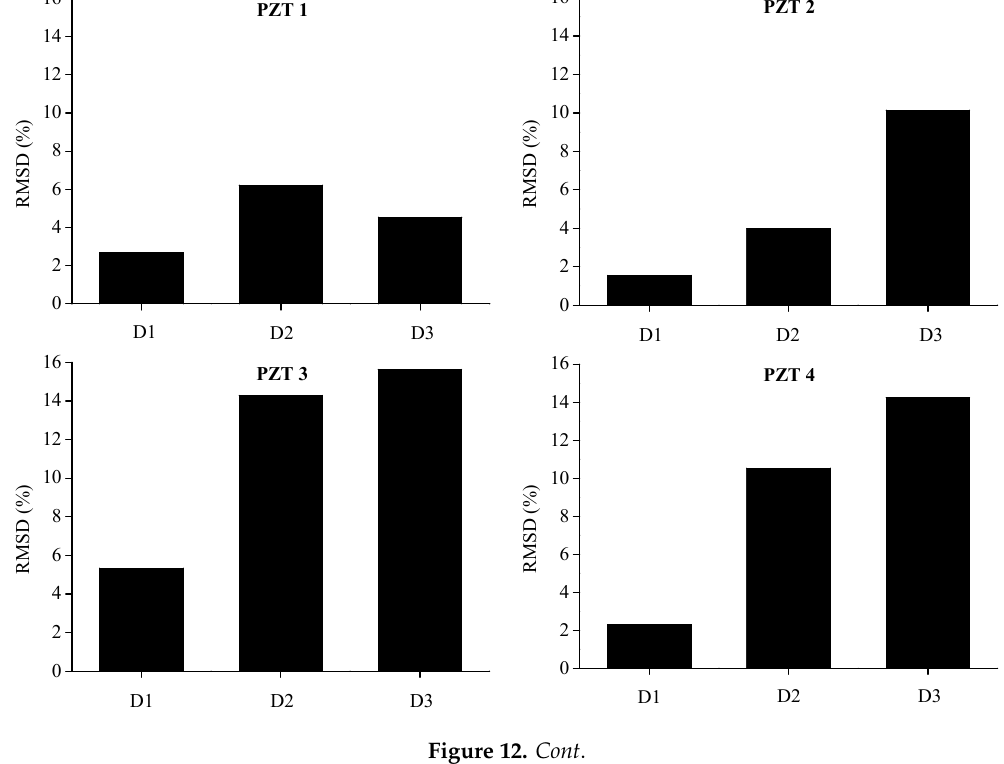
Figure 11. Experimental RMSD values of each PZT sensor for BE1 under different damage levels.